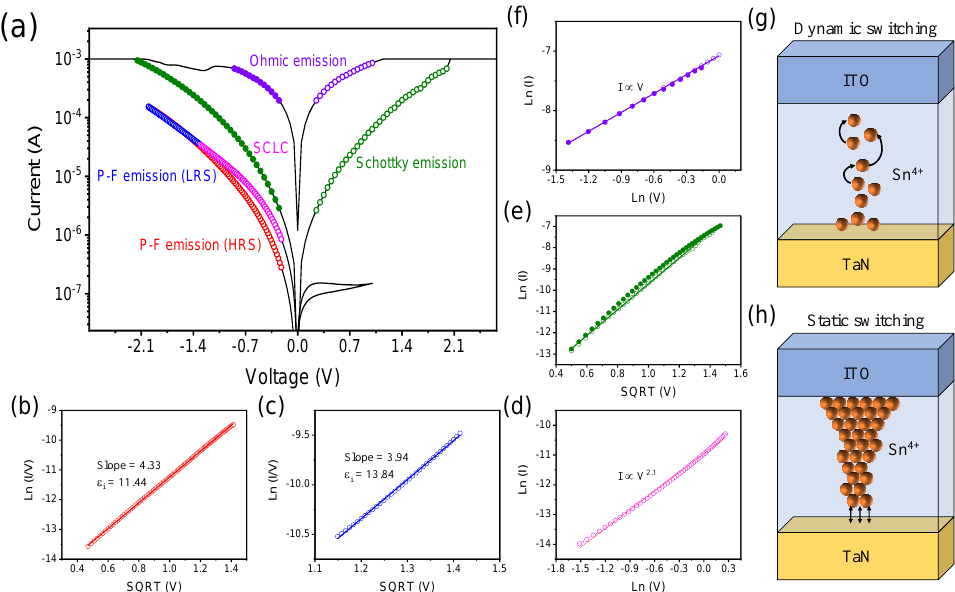
Figure 3. ( a ) Expressed conduction mechanism according to the linear fitting on the dynamic and static curves. The Pool – Frenkel emission in the dynamic curve of the ( b ) HRS and ( c ) LRS. ( d ) The LRS in the dynamic curve dominated by space charge-controlled current followed the Mott – Gurney law (I~V 2 ). The linear fitting of ( e ) Schottky emission and ( f ) Ohmic conduction (I~V 2 ) in the static curve. ( g ) Filamentary model of dynamic switching with P-F emission. ( h ) Filamentary model of static switching with Schottky emission.